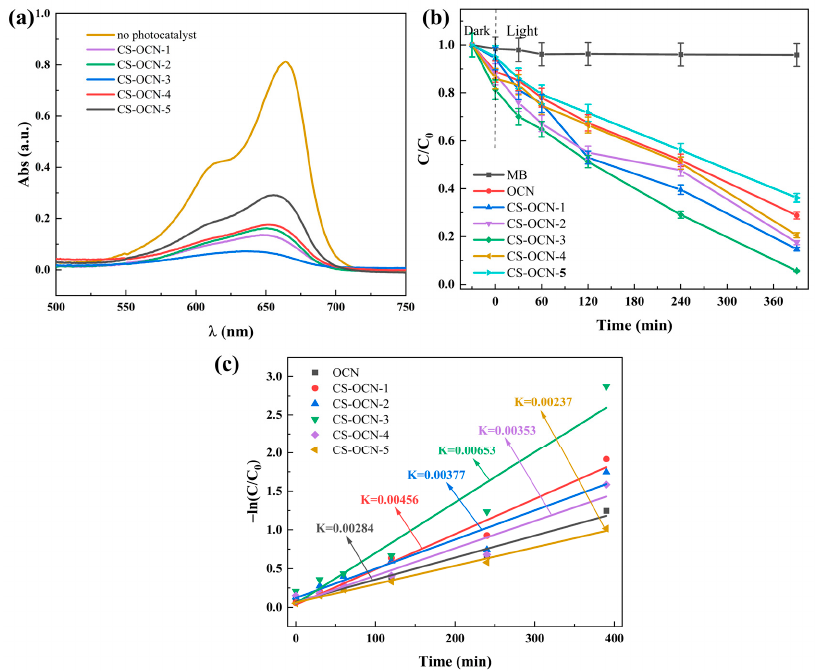
Figure 5. ( a ) UV-Vis absorption spectra, ( b ) Photocatalytic degradation curves and ( c ) Primary kinetic fi tt ing curves of CS-OCN for MB.